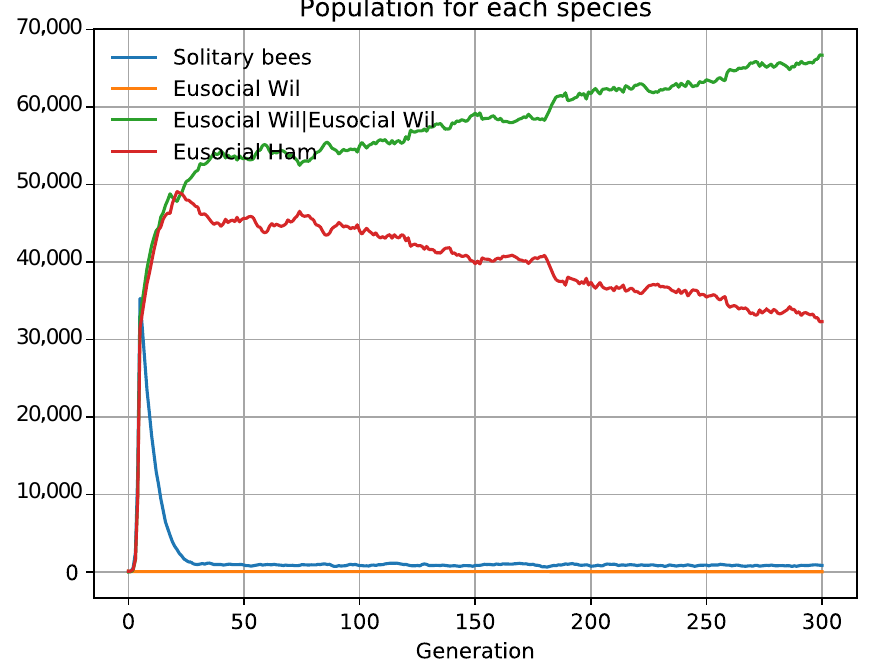
Figure 6. The theories of multilevel selection and kin selection are functionally equivalent. To represent eusociality, we use multilevel selection or kin selection in two different species. Neither prevails, the two species remain in evolutionary equilibrium. This means that both theories explain the same concept and are equivalent in their operation.